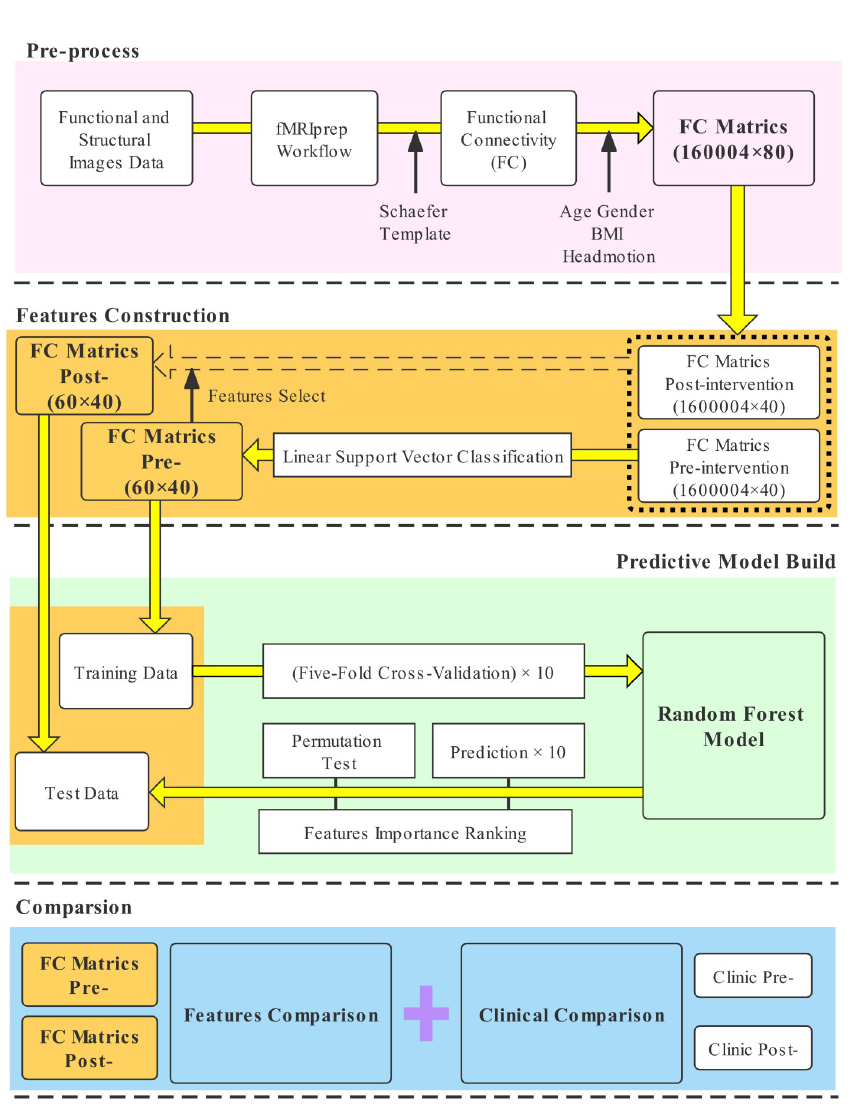
Fig 2. The workflow of the predictive model building in the